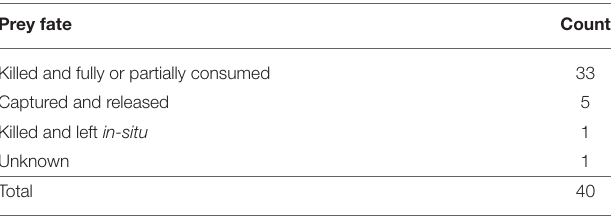
determining prey composition data. A higher rate of prey identification in the current study may also have altered